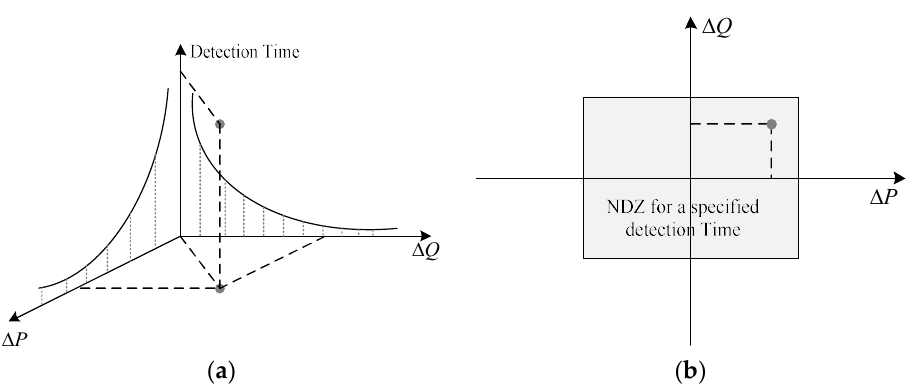
Figure 3. Power imbalances in a ∆ P − ∆ Q plane: ( a ) Power imbalance at a specified detection time, ( b ) non-detection zone due to insufficient power imbalance values [32].